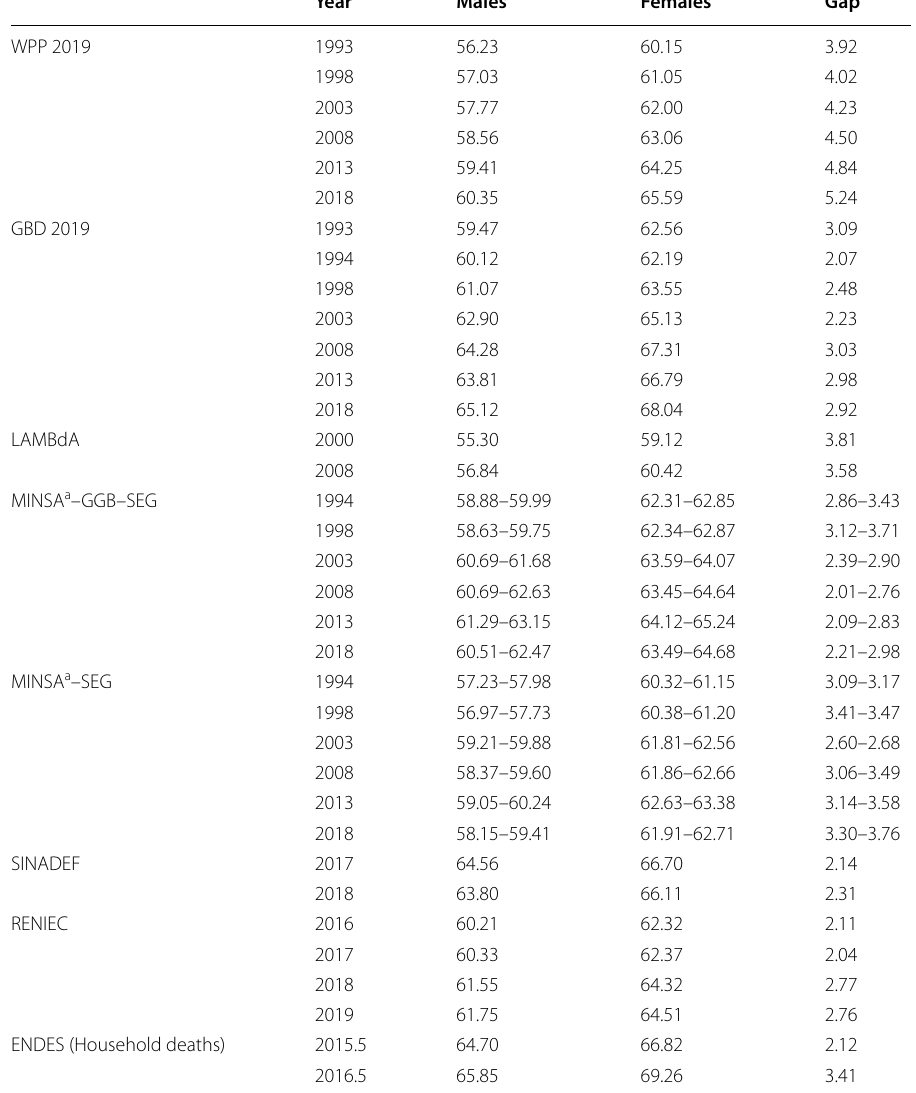
Table 8 Life expectancy at age 15 and gap estimates for selected years and data